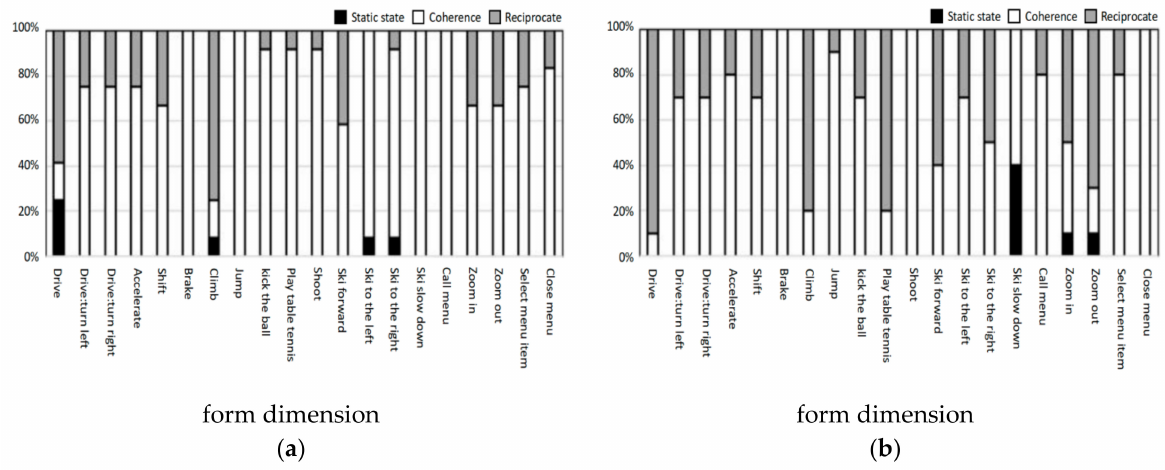
Figure 6. ( a ) Action distribution of young group in the form dimension; ( b ) action distribution of elderly group in the form